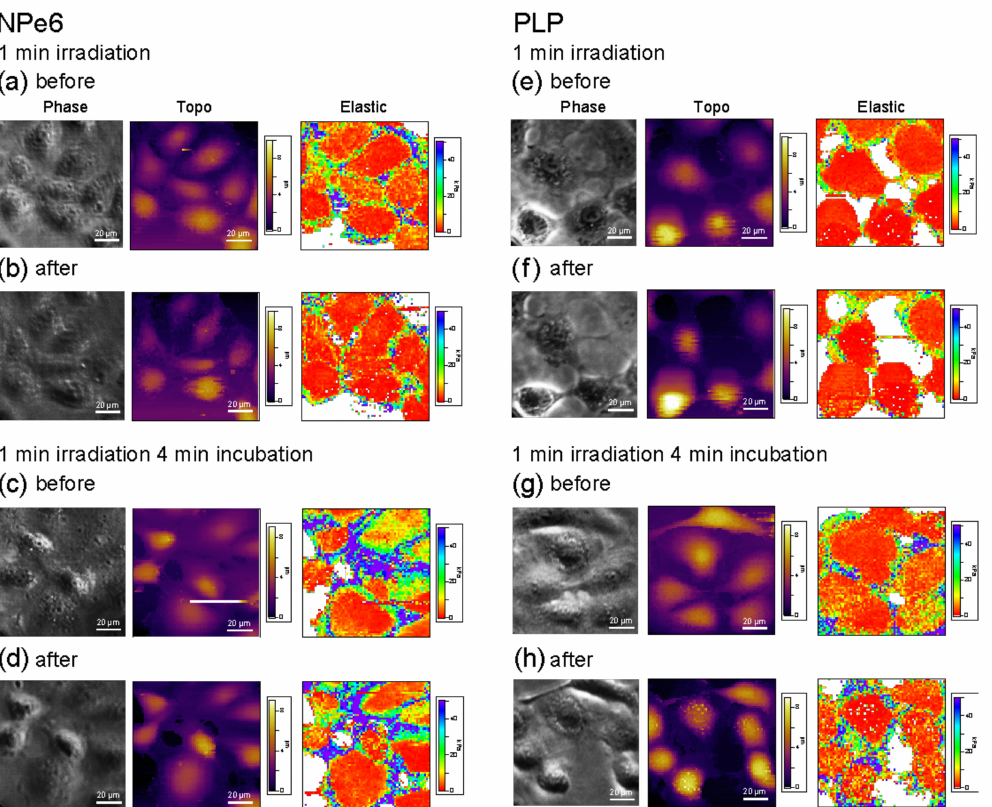
Figure 6. Phase-contrast images, topographic images, and elastic modulus maps of RGK1 with added NPe6 ( a – d ) and PLP ( e – h ) after 1 min of light irradiation and 4 min of standing in an incubator at 37 ◦ C with 5% CO 2 concentration. Force curves were measured at 64 × 64 points in an area of 100 µ m × 100 µ m. The topo images were obtained by mapping the height when a force of 200 pN was measured. The elastic modulus was evaluated using Hertz’s formula [38].